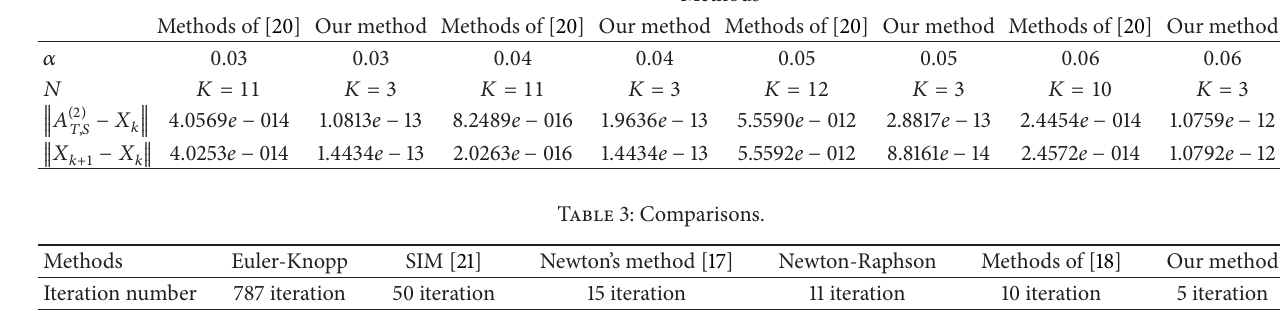
Table 2: Comparison of 𝑁 and error bounds for different values of 𝛼 . Methods